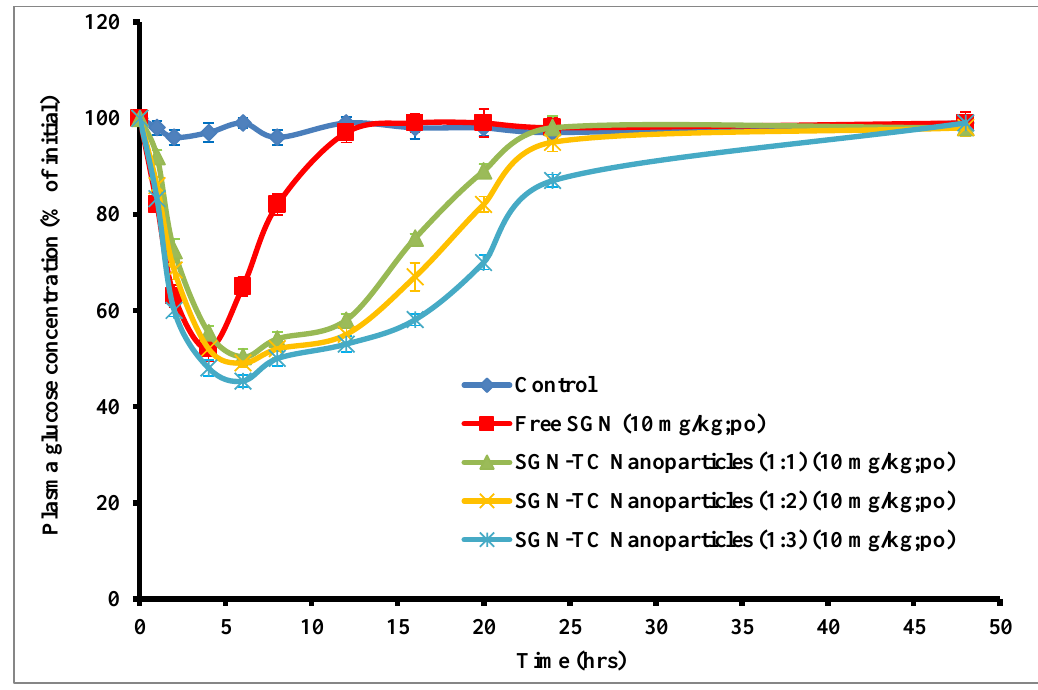
Figure 10. In vivo hypoglycemic efficacy of SGN–TC nanoparticles in comparison with free SGN .